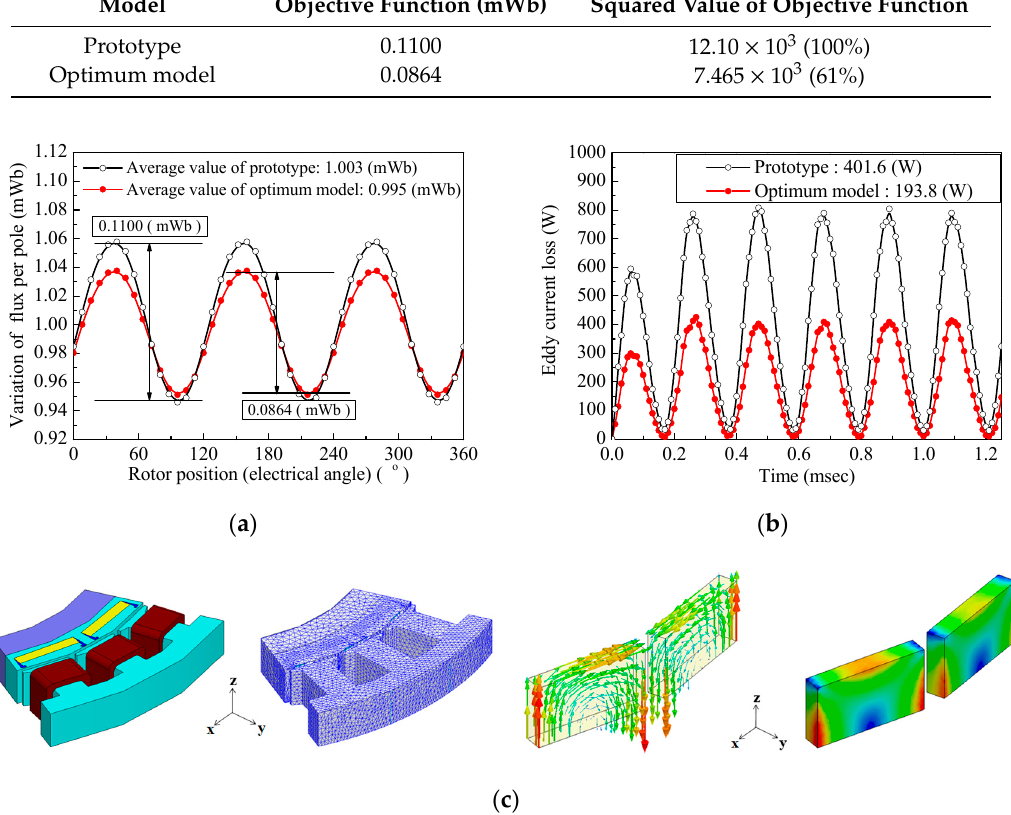
Figure 9. Comparison of flux variation and eddy current loss in the PMs. ( a ) Flux variation of PM per pole according to rotor position; ( b ) eddy current loss in PMs; ( c ) 3-D model for FEA and eddy current distribution. Table 5. Comparison of objective function and its squared value.